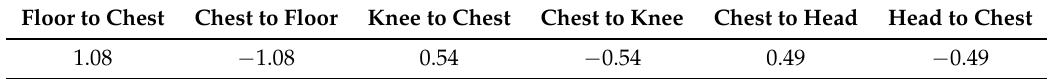
Table 3. The vertical displacement reference values in